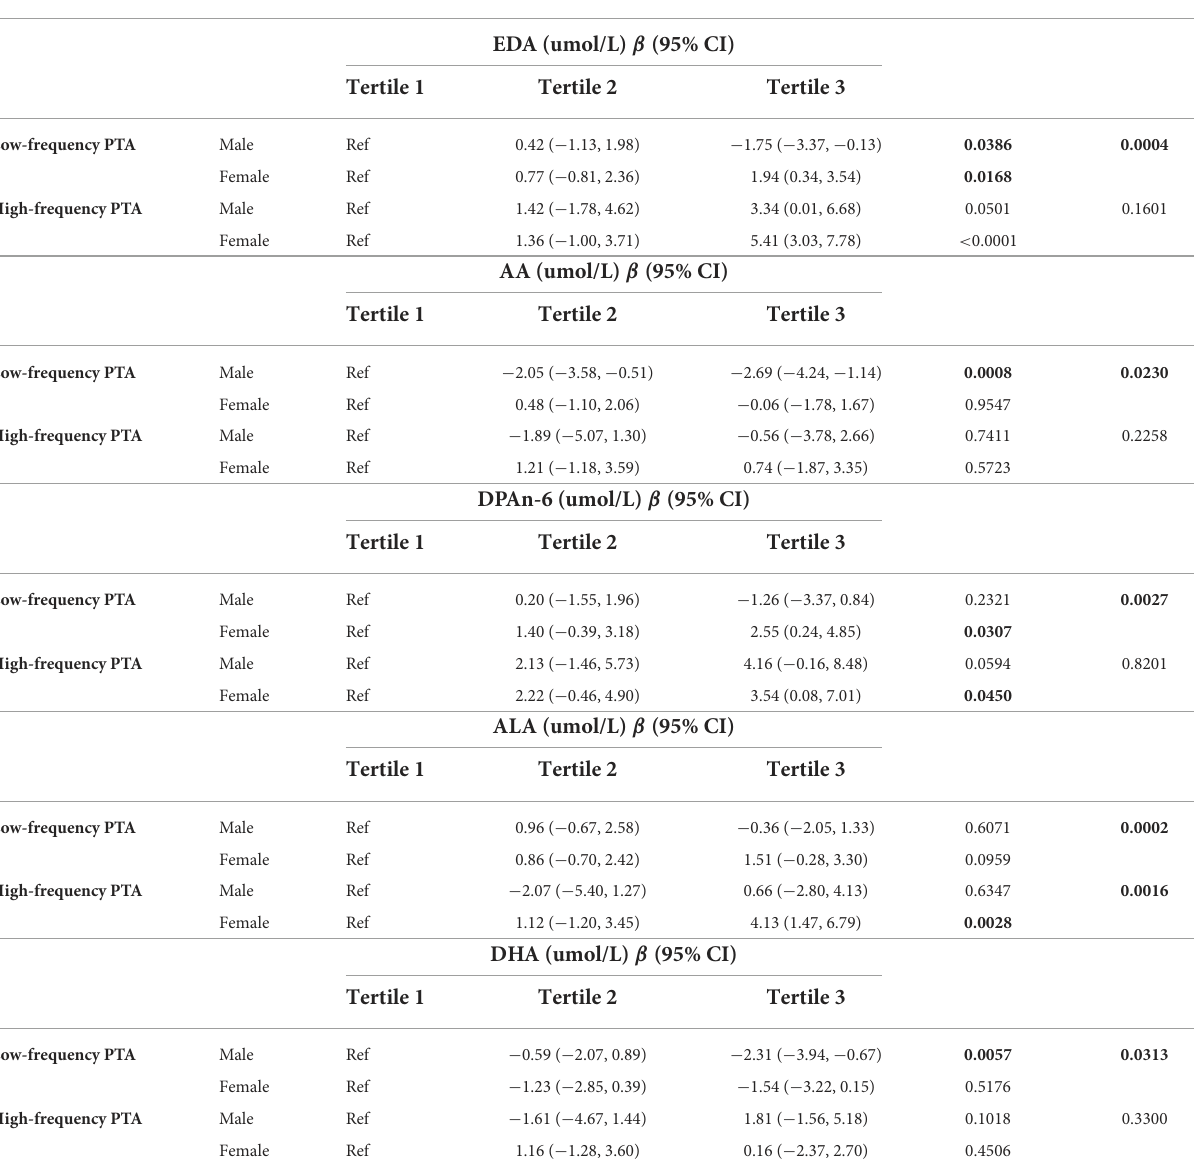
TABLE 4 Adjusted a associations between PUFAs and hearing threshold shifts stratified by sex ( N =